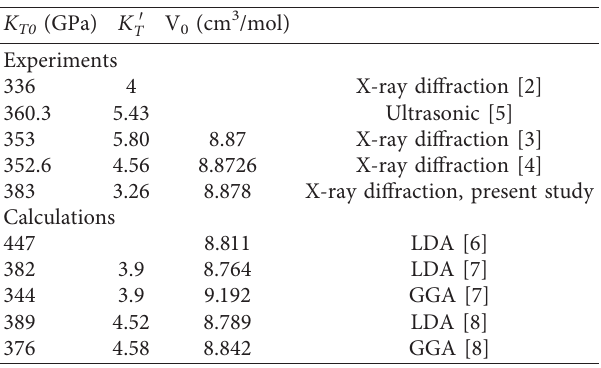
Table 2: Comparison of the elastic parameters of Re at room temperature.